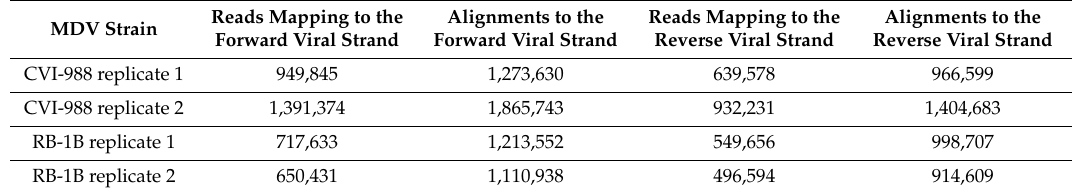
Table 1. Alignment statistics for our dataset (reads were produced using a directional sequencing protocol). To each read, one or more alignments can correspond (for instance, a read might align to both terminal